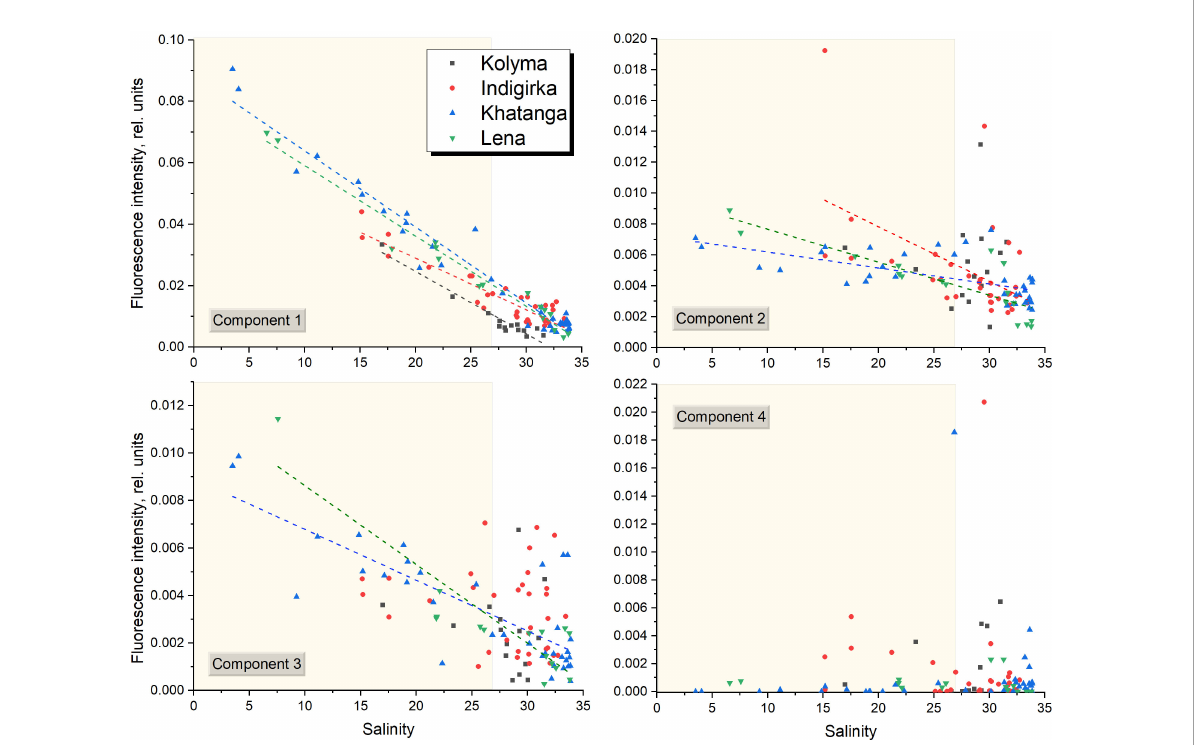
FIGURE 8 All samples from the 69 th cruise of R/V Akademik Mstislav Keldysh collected in the Laptev and East Siberian seas, showing fl uorescence intensity of PARAFAC components plotted against salinity. Yellow rectangles show the data obtained from the river plume regions with salinity below 27. The equations for linear correlations (dashed lines) are given in Table 4.